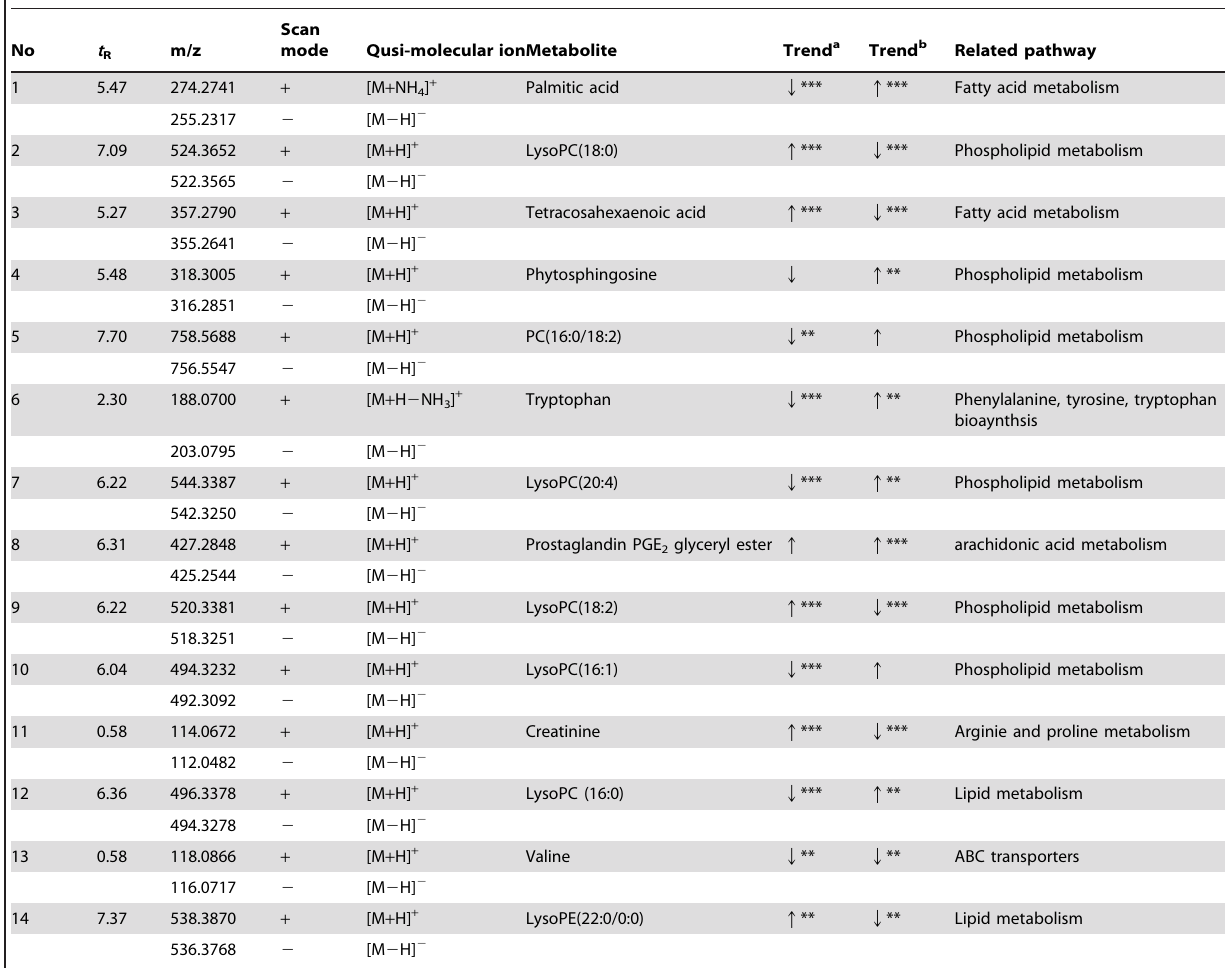
Table 1. Identification of significantly differential endogenous metabolites in the rat